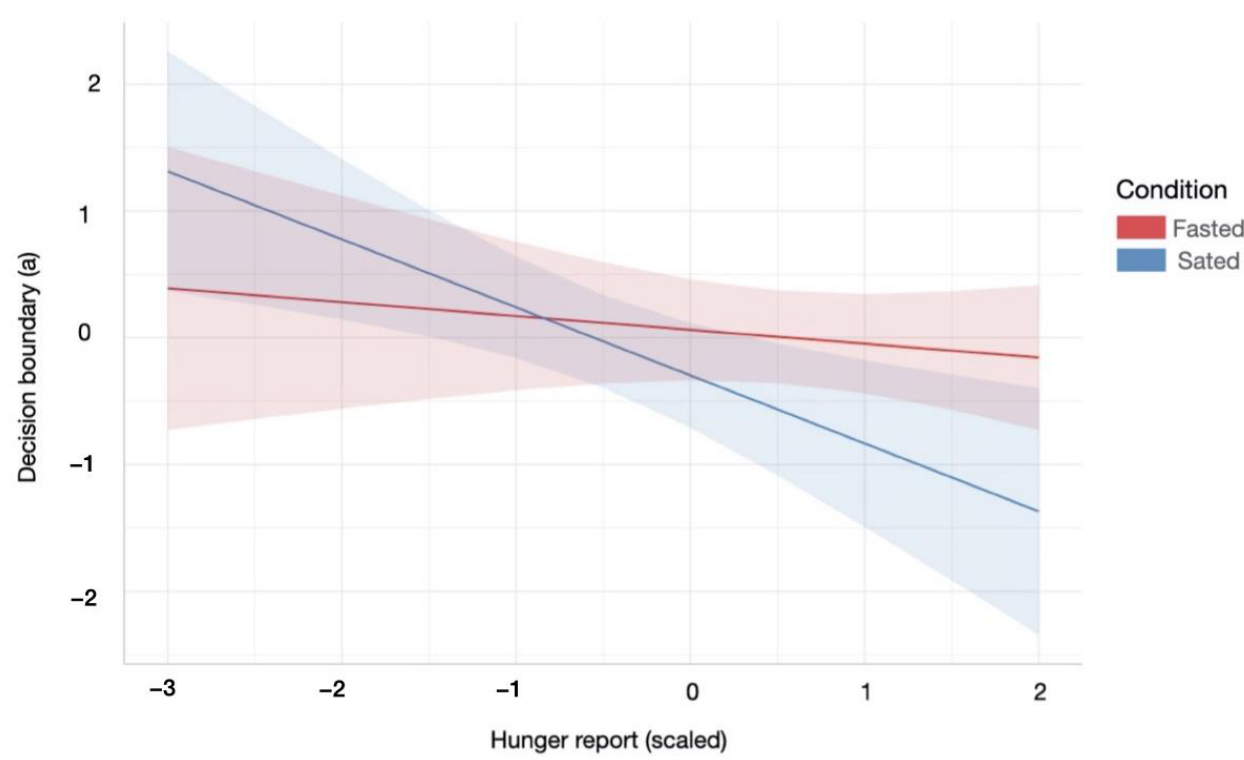
Figure 4. Relationship between the decision boundary parameter of the DDM and subjective hunger reports across hunger and satiety. Participants were less conservative in their information accumulation in order to make a decision during the satiety condition, with increased hunger levels. Red/blue coloured area indicates 95% confidence interval of linear model’s predictions. For statistical details refer to main text (Section 3.2.1.).